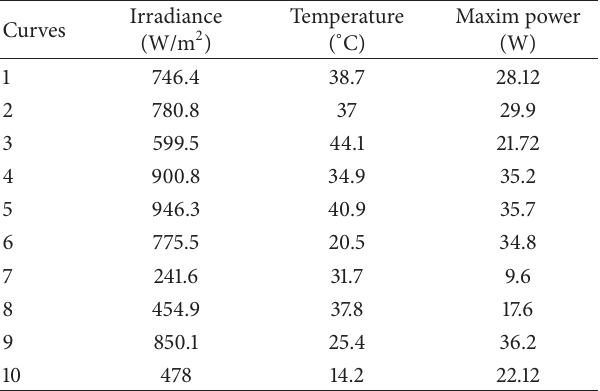
Table 4: Environmental conditions of the I - V solar panel curves.